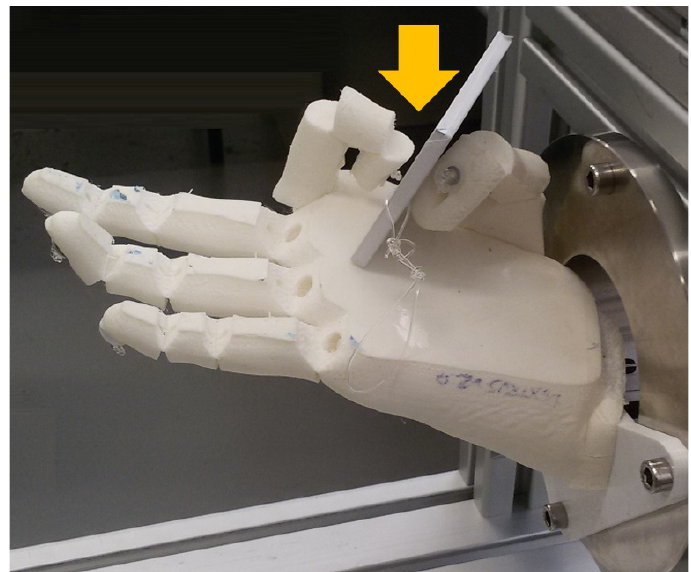
Figure 12. Under high tension at the tendons, Dextrus digits bend excessively, and the hand cannot grasp thin plates with LP, PP or EG (see gap pointed out, for PP). Although some functionality was demonstrated, this hand had to perform the SHAP tasks with the plate using alternative ways of